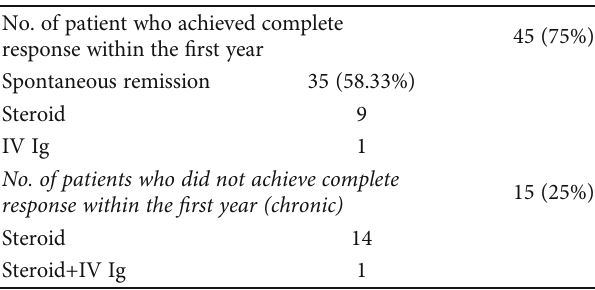
Table 3: Fate of the disease and response to